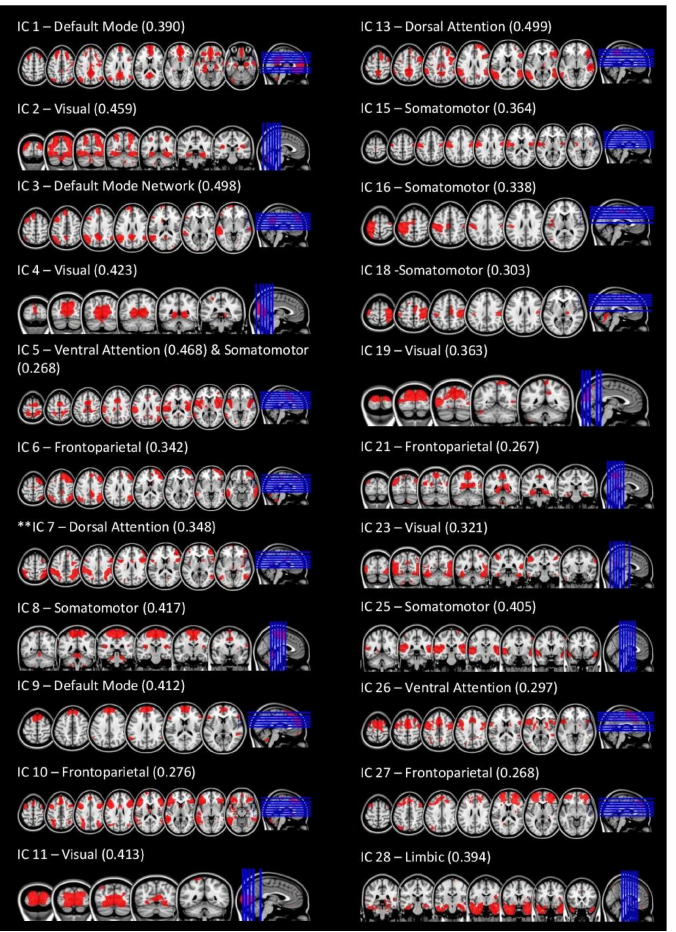
Figure 1. Results for Group ICA. Independent components (IC) were labeled and organized based on their cross-correlations with Yeo’s (2011) networks. Above is each IC, the associate Yeo network(s), and the cross-correlation coefficient between the two. ** Denotes Network of